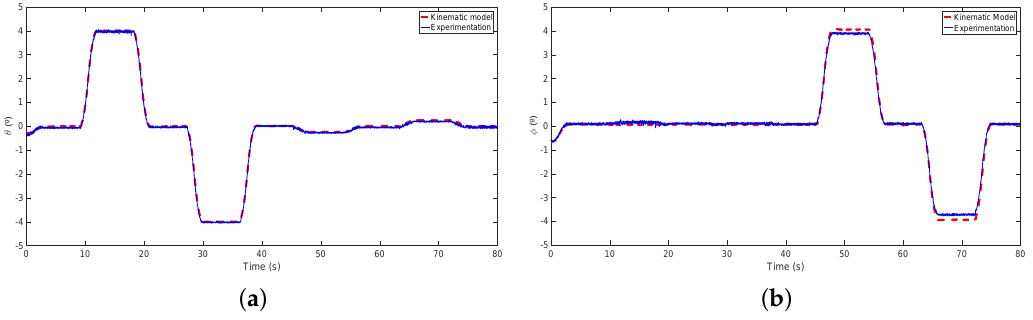
Figure 11. ( a ) validation of the pitch angle ( θ ); ( b ) validation of the roll angle ( φ